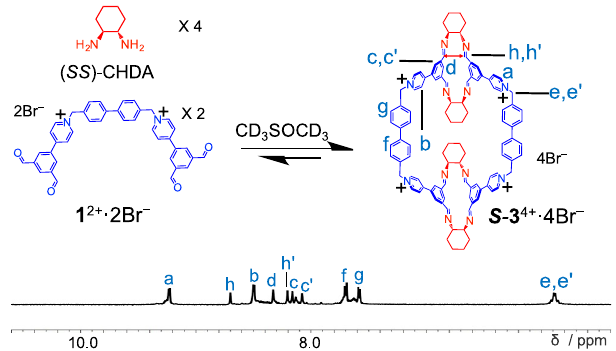
Fig. 3 Partial 1 H NMR spectra (600MHz, 298K, CD 3 SOCD 3 ) of S -3 4 + ·4Br – . S -3 4 + · 4Br – was obtained by heating a 1:2 mixture of 1 2 + ·2Br – (2 mM) and ( SS )-CHDA (4 mM) at 80 °C for 12 h in CD 3 SOCD 3 .